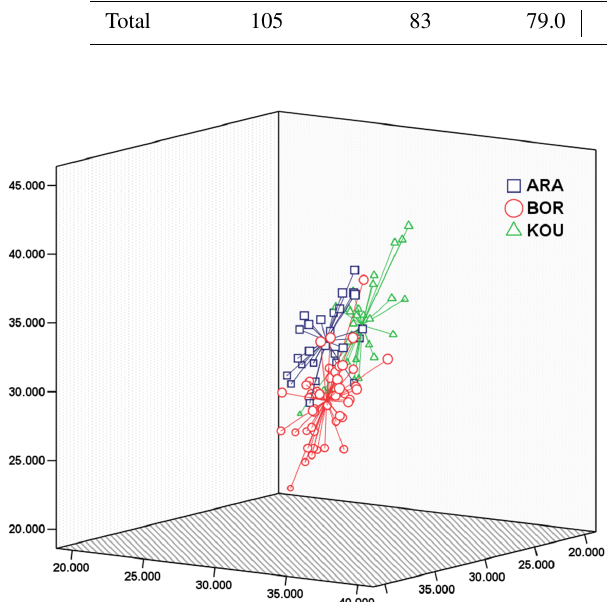
Figure 3. Scatter plot of log-likelihood estimates (Baudouin and Lebrun, 2001) for different individuals of Zebu Arabe (ARA), Zebu Bororo (BOR) and Kuri (KOU) breeds of Niger